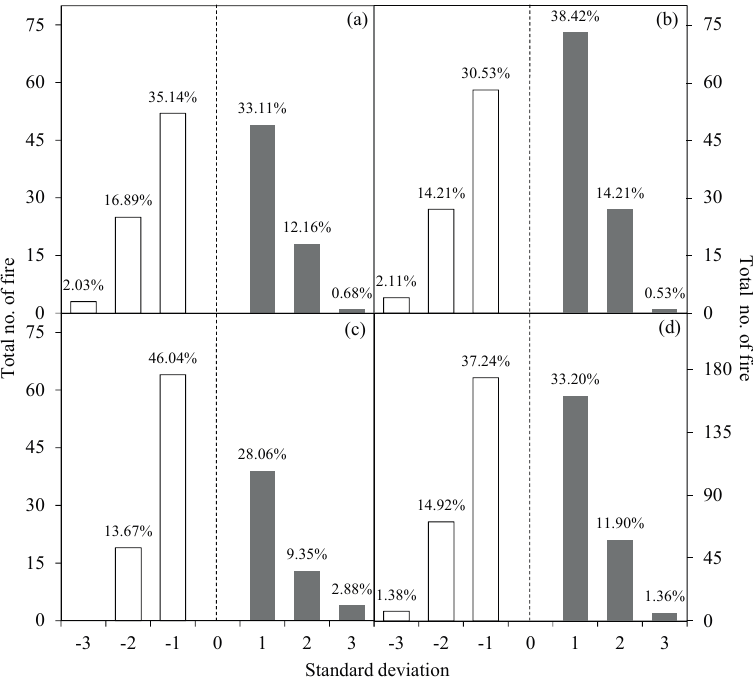
Figure 4. Frequency distribution of the fires with respect to the PW variable and its corresponding study area average values during the j day when actual fires occurred in the following j + 1 day on the basis of the “study area-specific average ±3 standard deviation” values and percentage of fire spots during ( a ) 2009, ( b ) 2010, ( c ) 2011, and ( d )